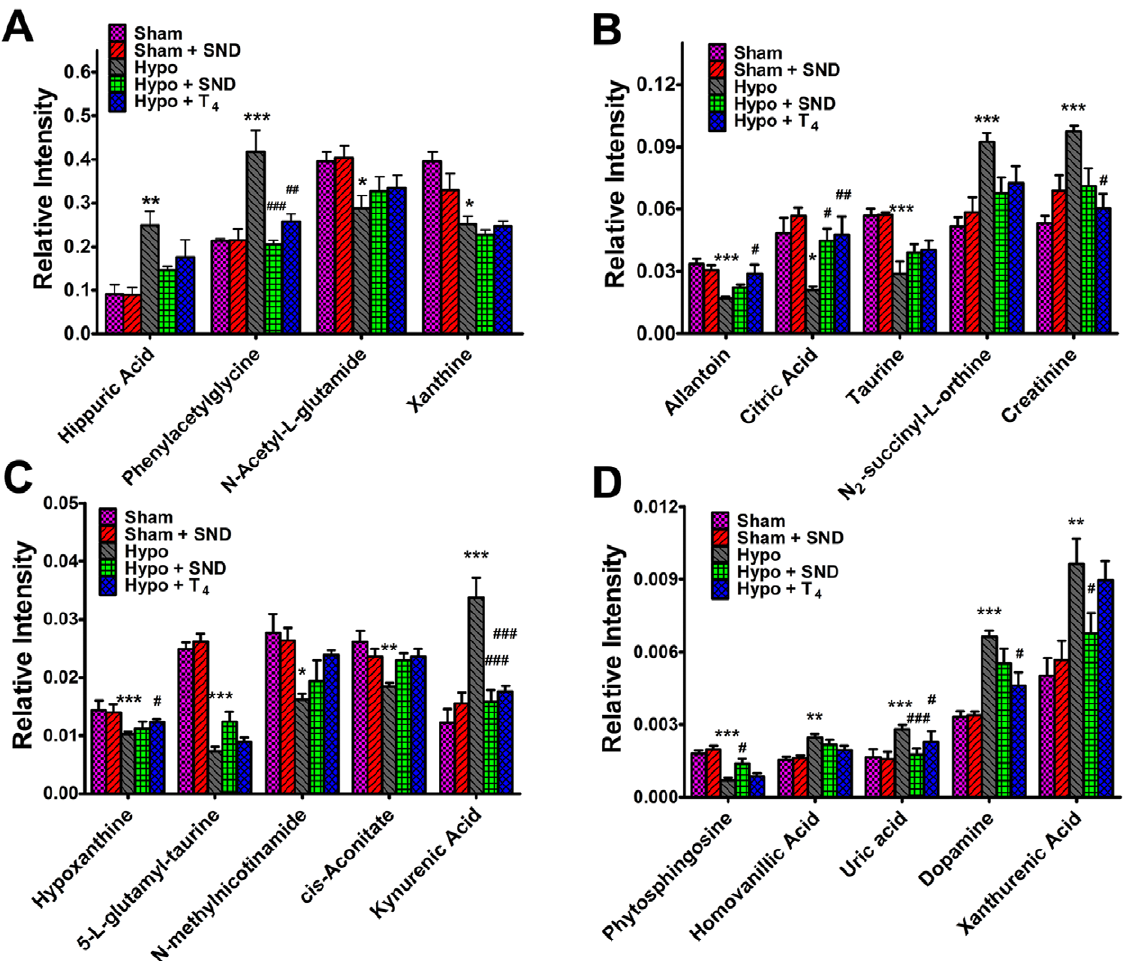
Figure 6. Comparison of different ions in urine of Sham group, Sham + SND group, Hypo group, Hypo + SND group and Hypo + T 4 group after 4-week treatment. * p -Value , 0.05 compared to Sham group, ** p -Value , 0.01 compared to Sham group, *** p -Value , 0.001 compared to Sham group; # p -Value , 0.05 compared to Hypo group, ## p -Value , 0.01 compared to Hypo group, ### p -Value , 0.001 compared to Hypo